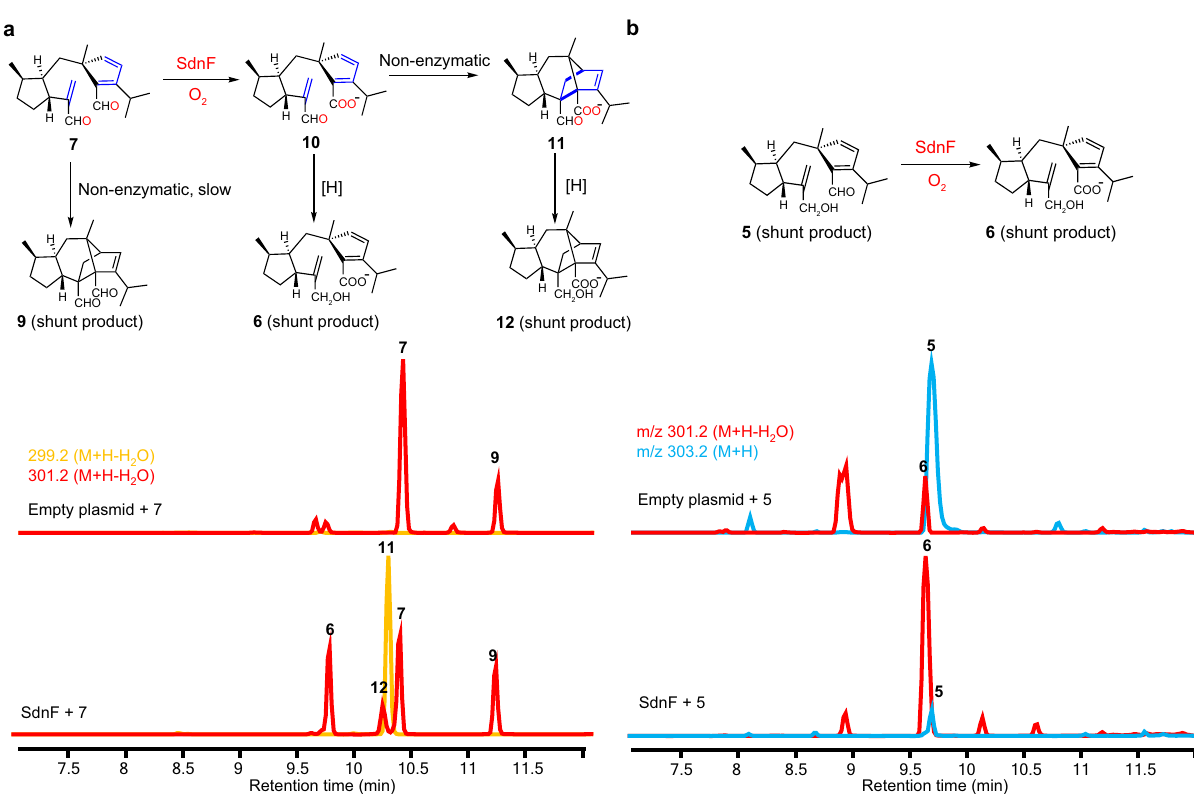
Fig. 5 Biotransformation probing the function of SdnF. a Biotransformation of 7 by A.nidulans expressing SdnF. b Biotransformation of 5 by A.nidulans expressing SdnF. The chromatograms in all cases are extracted from mass spectra of the base peak for each